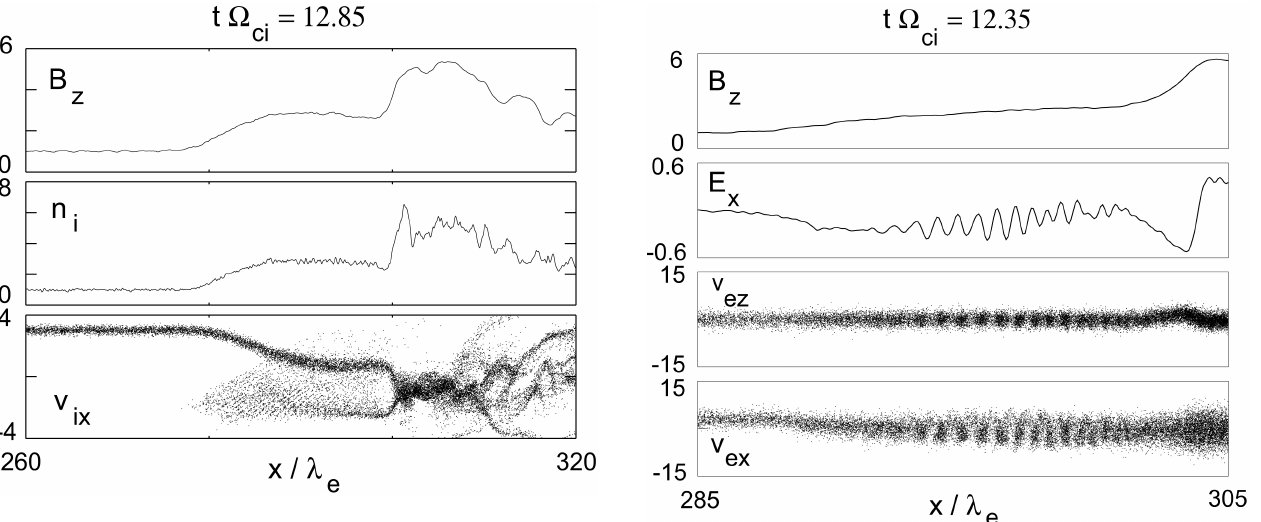
Fig. 1. From top to bottom: magnetic field B z component, ion den- sity n i , and ion v ix phase space versus shock normal direction x for the ion to electron mass ratio 80 run.